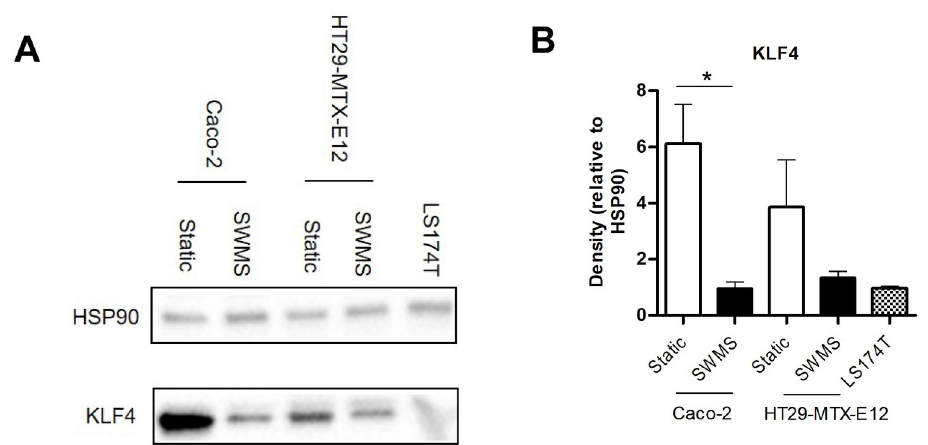
Fig 3. Protein expression of KLF4 in HT29-MTX-E12, Caco-2 and LS174T cells grown under static and/or SWMS conditions. A) Western Blot results of KLF4 and HSP90 (house-keeping protein) in Caco-2, HT29-MTX-E12 and LS174T-cells grown under static and SWMS conditions or static only (LS174T). Of each condition, one representative biological replicate is shown. See S5 Fig for all replicates. B) KLF4 protein quantity expressed as the protein band density relative to HSP90. � p < 0.05, n = 3 biological